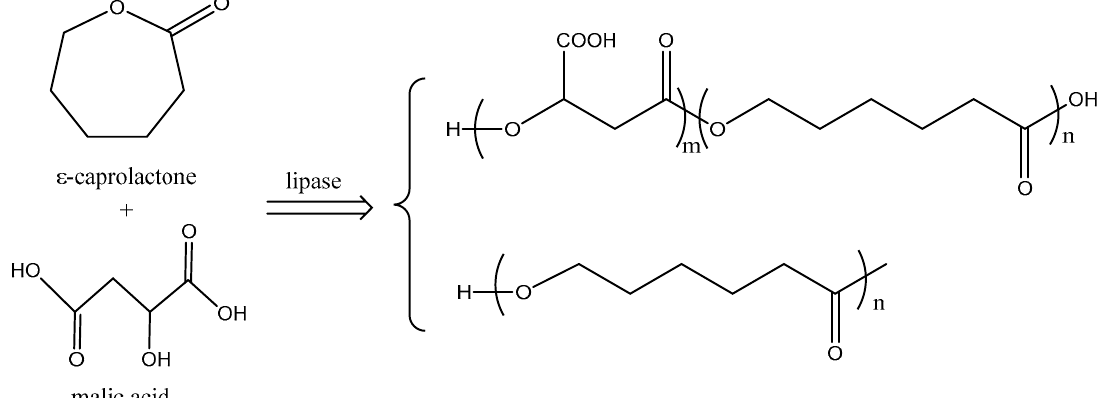
Figure 1. Reaction scheme of the polycondensation reaction of ε -caprolactone with malic acid, catalyzed by lipase, yielding oligoester products.